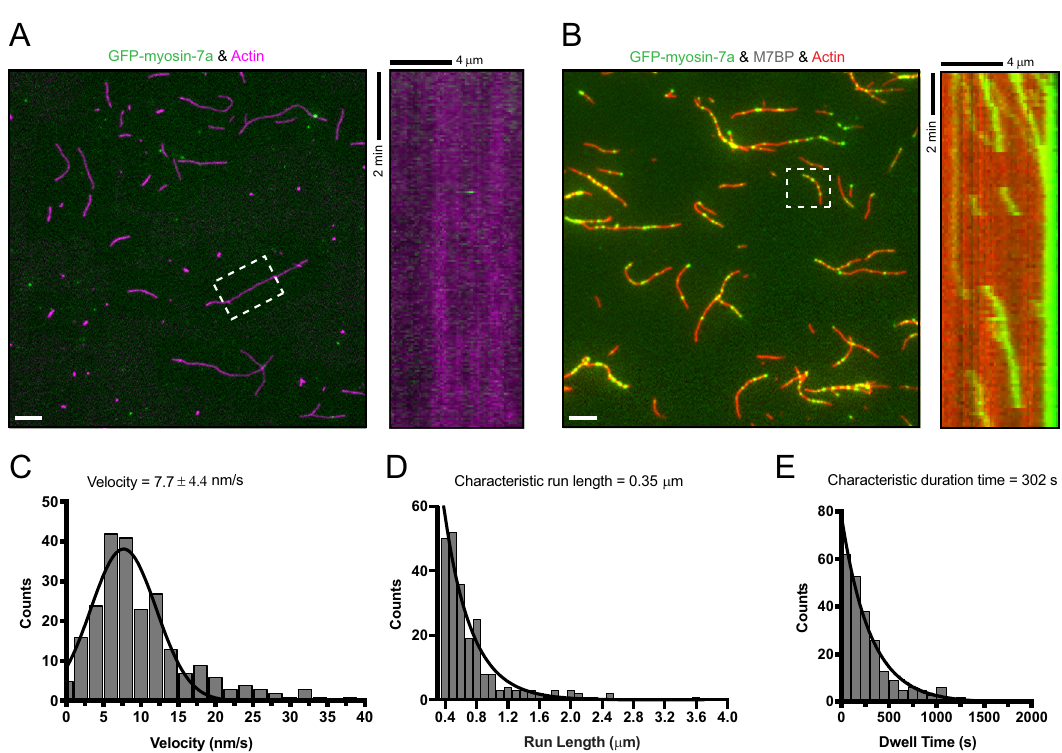
Fig. 2 M7BP enables highly processive motility of myosin-7a along actin fi laments. A Left panel: A single time frame of GFP-myosin-7a alone on immobilized actin fi laments (labeled with Alexa-Fluor 647 phalloidin, magenta). Right panel: Kymograph analysis of the box region in A showing that no processive movement was detected. Note the transient appearance of GFP-myosin-7a, which is indistinguishable from its binding to the background surface. Scale bar = 5 μ m. B Left panel: A single frame taken from the time-lapse recordings of GFP-myosin-7a (green) with unlabeled M7BP. Actin is labeled with Rhodamine phalloidin (red). Right panel: Example kymographs (box region in B ) show clear processive movements along actin fi laments. Scale bar = 5 μ m. C – E Frequency distribution histograms of the velocity (mean ± SD) ( C ), characteristic run length ( D ), and characteristic run duration ( E ), respectively for the GFP-myosin-7a in the presence of unlabeled M7BP. N = 231 processive Fig. 1G-I). The near complete absence of free myosin-7a species is consistent with the high af fi nity of M7BP for myosin-7a. M7BP moderately enhanced the steady-state ATP turnover at low concentrations of actin (Supplementary Fig. 1H), but had no effect on ATPase rates of skeletal-muscle myosin (Supplementary Fig. 1I). Together with EM data, the results show that M7BP activates ATPase activity in myosin-7a by binding to the C- associations.